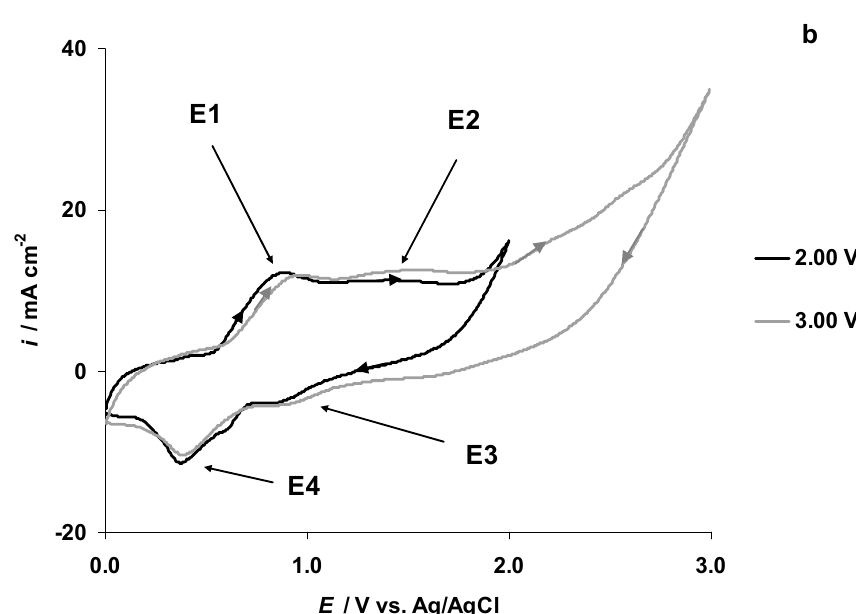
Figure 12. Cyclic voltammetry (CV) data for positively polarized C(Mo 2 C) electrodes soaked in 5 wt % EMImBr solution in the EMImBF 4 solution: ( a ) located inside the XPS vacuum chamber (ca. p = 10 − 7 mbar) and ( b ) inside the very dry and oxygen free Ar-filled glovebox (ca. p = 1 bar) within the potential sweep ranges from 0.00 to 2.00 V and vice versa (black line) and from 0.00 to 3.00 V and vice versa (gray line). Data of second cycles have been presented measured at the potential scan rate of 1.0 mV s − 1 .